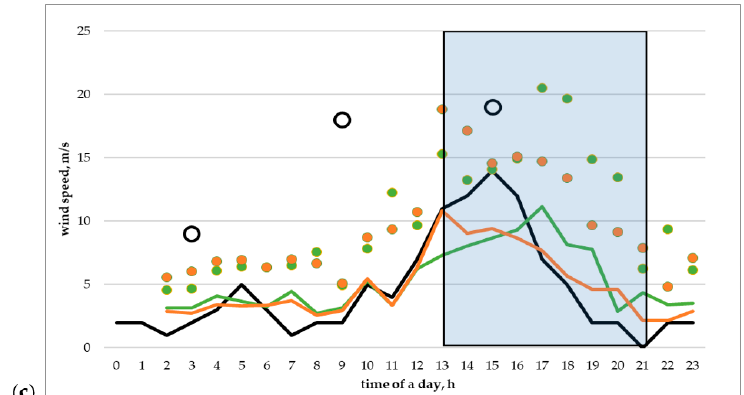
Figure 16. ICON-A6.5 (orange); ICON-A2 (green); observations (black): 10 m wind speed (curves) Figure 16. ICON ‐ A6.5 (orange); ICON ‐ A2 (green); observations (black): 10 m wind speed (curves) and wind gusts (circles) on 20 March 2020. ( a ) Airport Röst (67°31’ N, 12°06’ E); ( b ) Skrova light ‐ and wind gusts (circles) on 20 March 2020. ( a ) Airport Röst (67 ◦ 31’ N, 12 ◦ 06’ E); ( b ) Skrova lighthouse house (68°09’ N, 14°39’ E); ( c ) Airport Stokmarknes (68°35’ N, 15°01’ E). Squares show time peri ‐ (68 ◦ 09’ N, 14 ◦ 39’ E); ( c ) Airport Stokmarknes (68 ◦ 35’ N, 15 ◦ 01’ E). Squares show time periods of the ods of the appearance of polar lows. appearance of polar